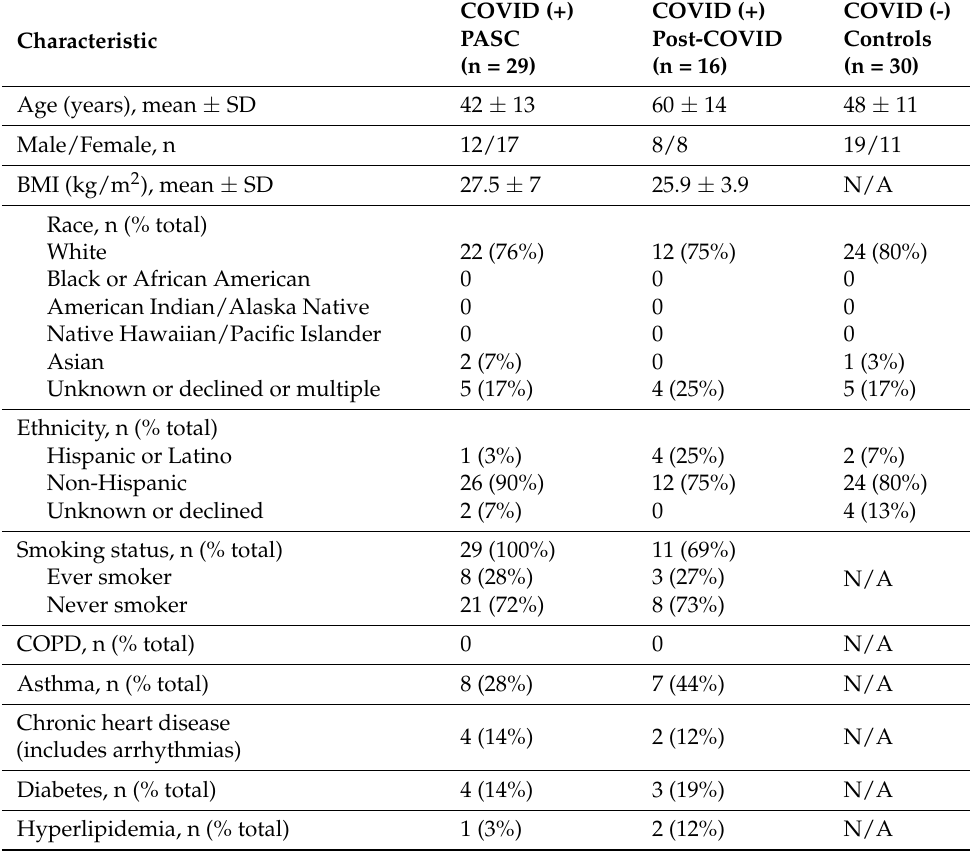
Table 1. Individual characteristics by COVID-19 status (from 16 March 2020 to 22 March 2020).